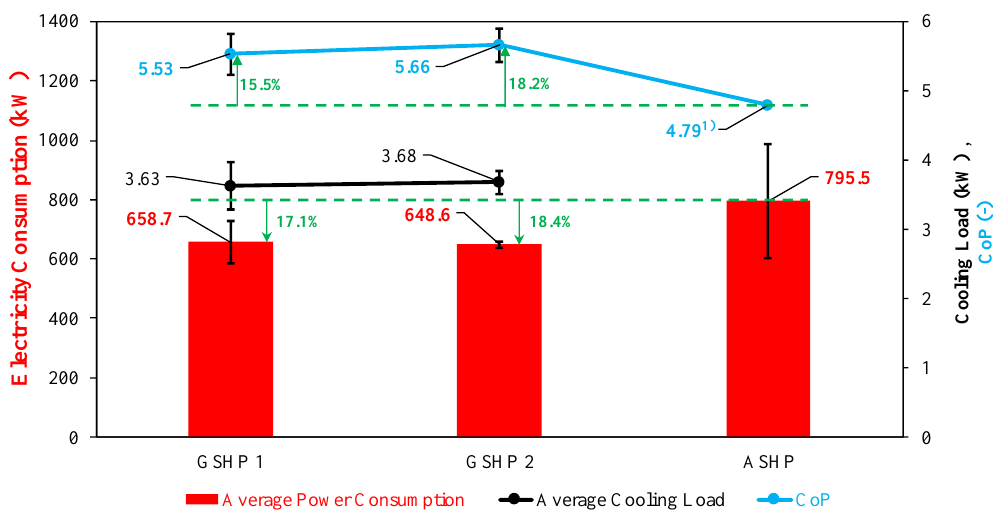
Figure 14. Performance comparison of the GSHPs and ASHP; the coefficient of performance (CoP) of the ASHP is calculated assuming an average cooling load similar to that of GSHP 1 and GSHP 2.